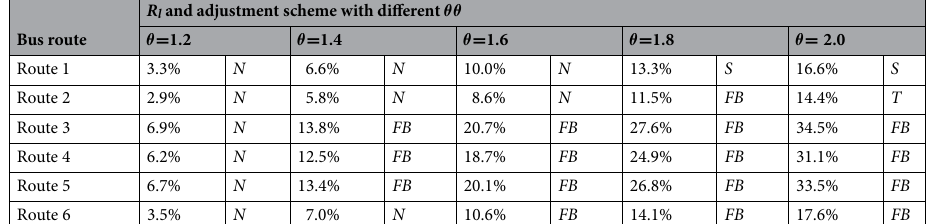
R l and adjustment scheme with different θθ θ = 1.2 θ = Bus route